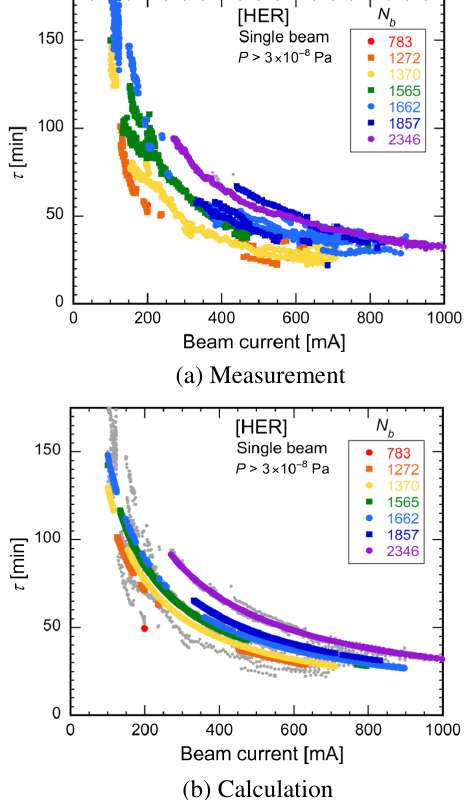
FIG. 17. Dependence of τ on I (a) measured and (b) calculated using the regression curve for several N b of 783 – 2346 from the 15th of March to the 22nd of June 2022 for the HER. Gray points correspond to all measured